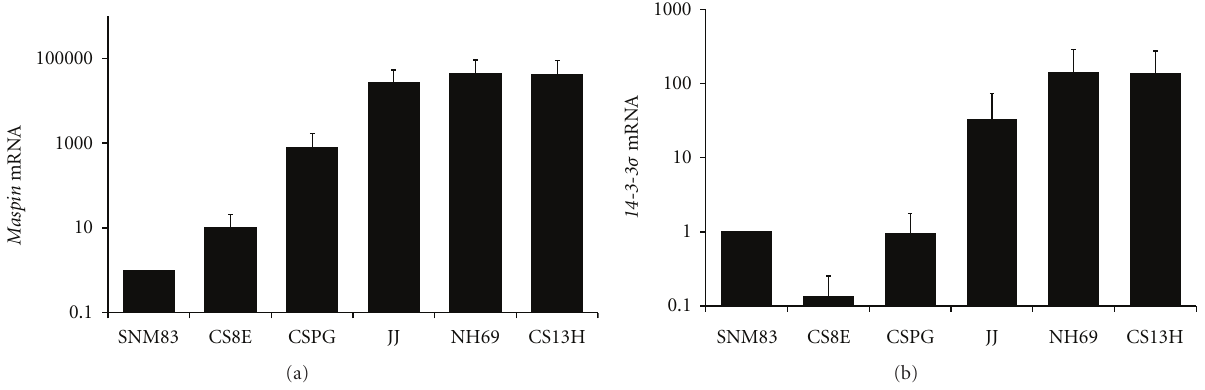
Figure 2: Chondrosarcomas acquire aberrant expression of epithelial-specific genes maspin and 14-3-3 σ . (a) Maspin mRNA expression was measured by real-time PCR. Four of the five chondrosarcoma cell lines (CSPG, JJ, NH69, and CS13H) showed a significant increase in maspin mRNA expression when compared to the normal SNM83 chondrocyte cell line. SNM83 had minimal expression but was set at 1 on